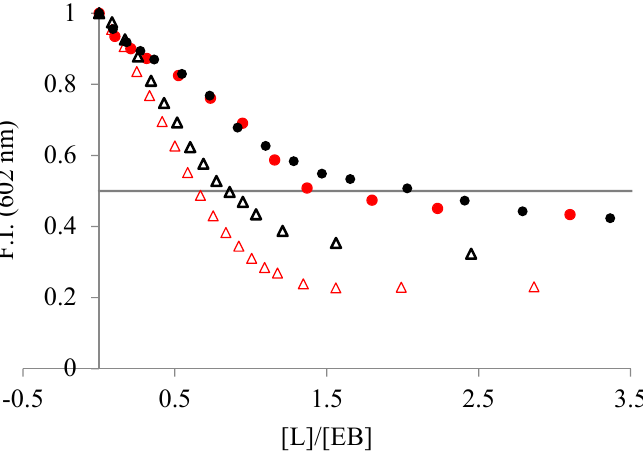
Figure 4. Changes in fluorescent emission obtained from EB displacement assays of ( • ) ctDNA and ( Δ ) poly A-poly U, 3–4 × 10 − 5 M, when titrated with (red) L1 and (black) L2 (NaCac 50 mM, pH 7.4). The line represents the emission decrease by 50% with respect to the initial value.